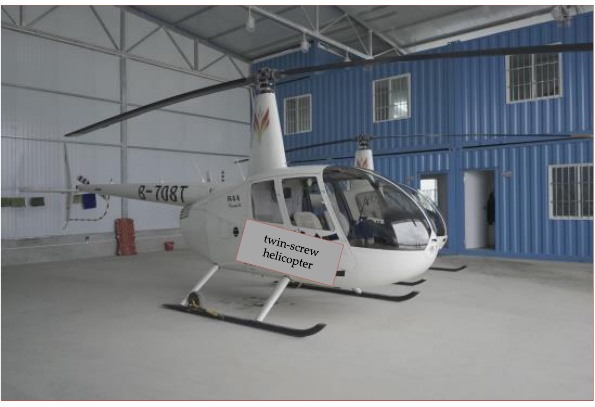
Figure 3. Robinson R44 helicopter.